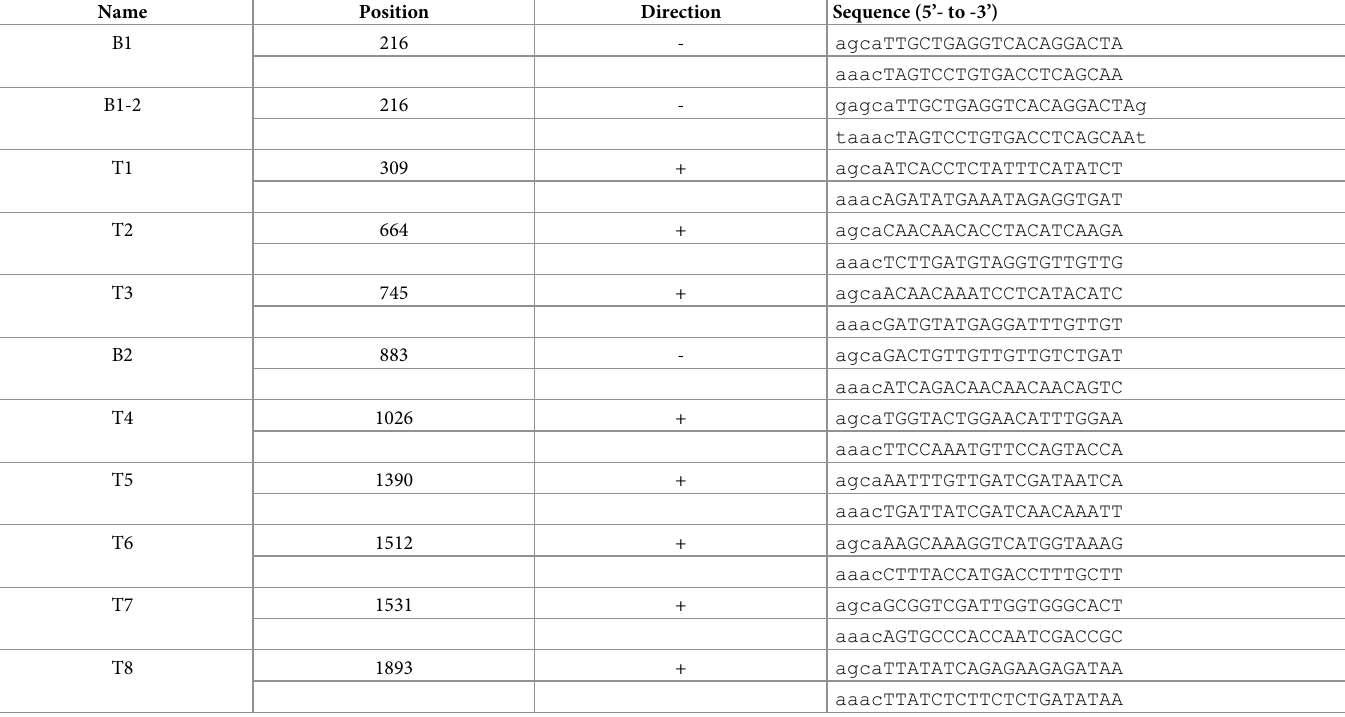
Table 1. List of oligonucleotides used to generate the sgRNA